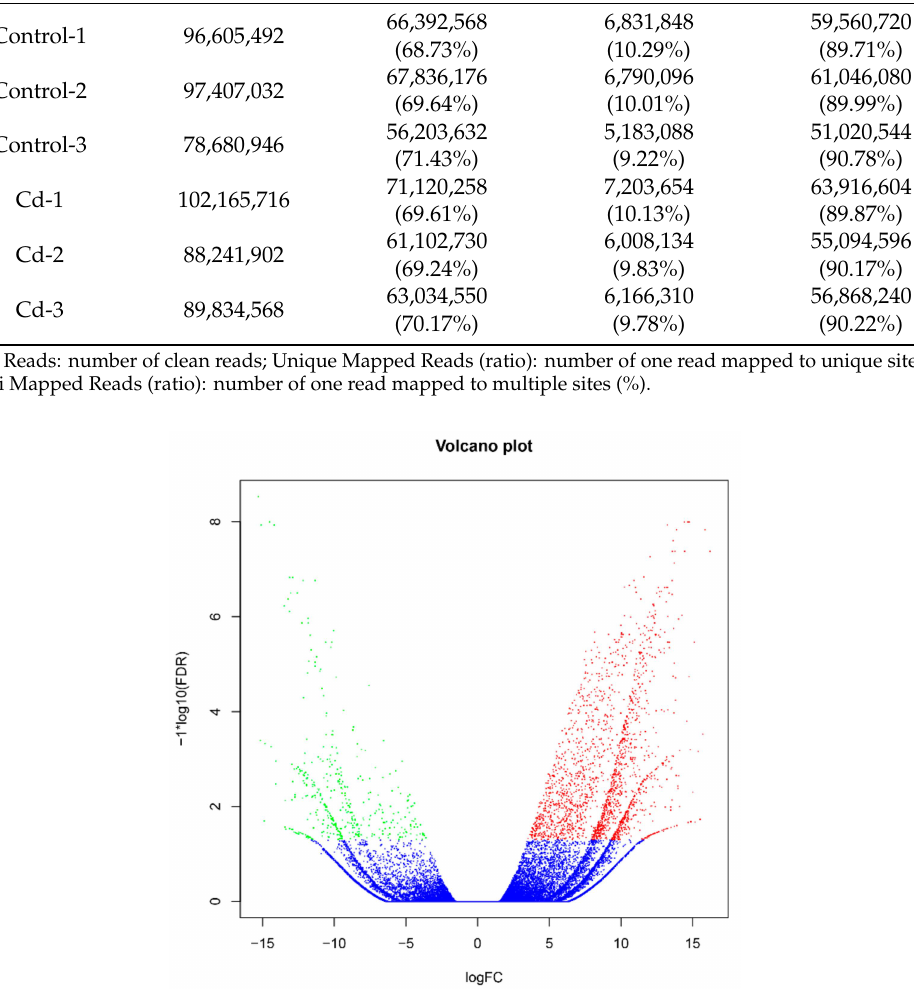
Figure 3. Distribution and expression levels of di ff erentially expressed genes (DEGs) in Italian ryegrass roots exposed or not to cadmium (Cd). The x-axis represents the log 2 [Fold Change] values under the mean normalized expression of all isoforms (y-axis). Red dots indicate the upregulated DEGs, and green dots represent the down regulated